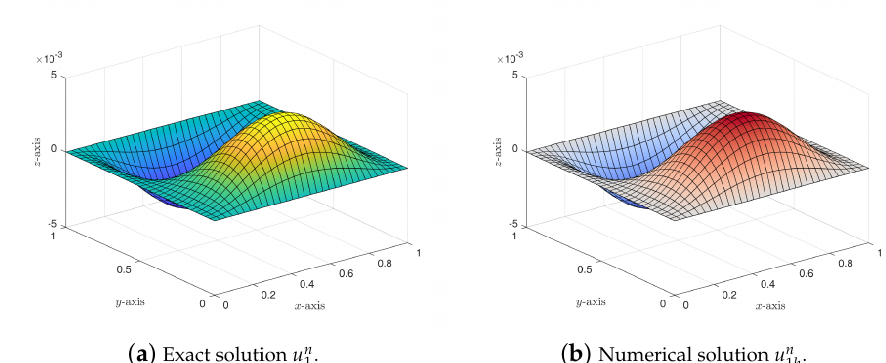
Figure 4. The graphics of u n